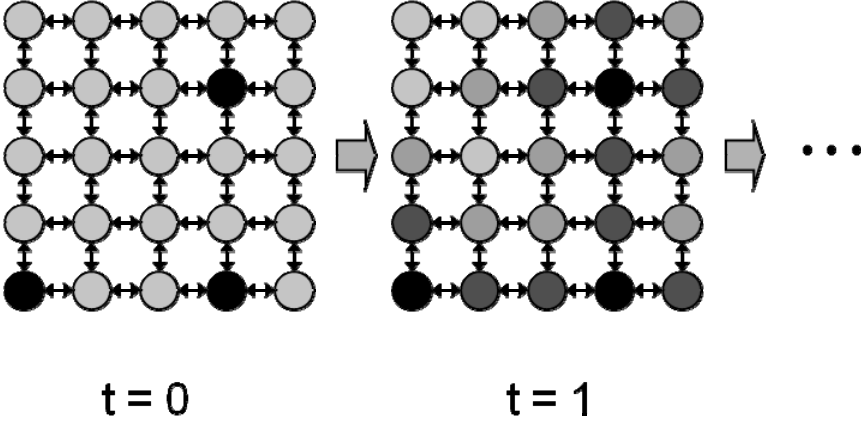
Figure 3. Two-dimensional schematic diagram of control signal